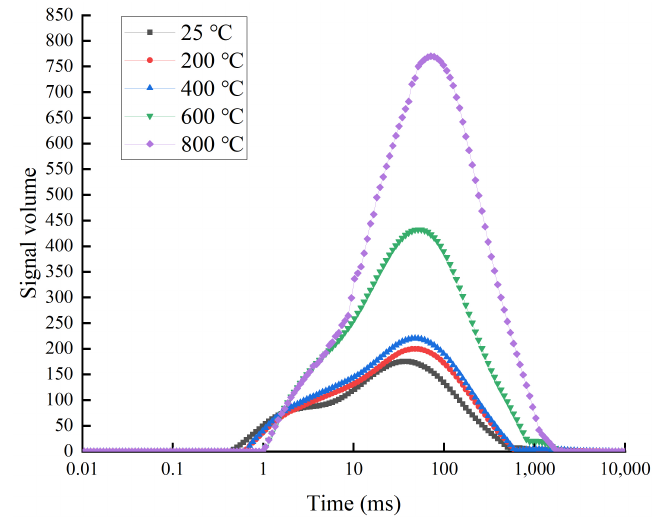
Figure 4. T 2 spectra from NMR on heat-treated Beishan